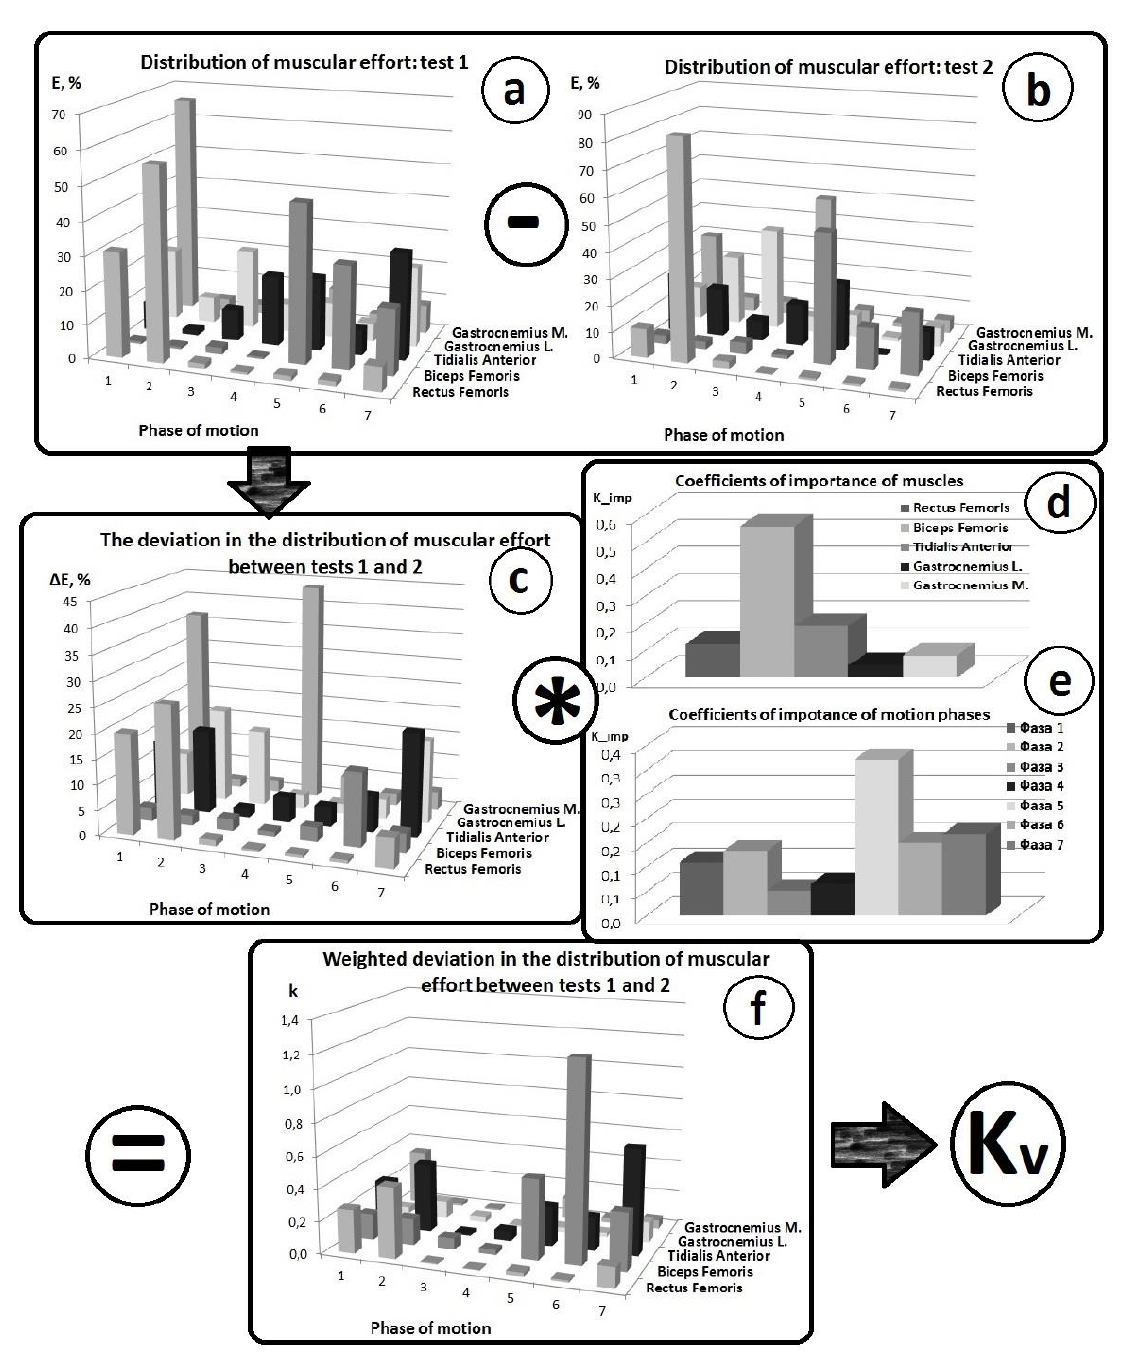
Figure 8. The stages of the estimation of the reproducibility of electromyographic patterns of motion with the influence of the external disturbing factor in the example of tests 1 and 2 for the left leg: a, b - the percentage distribution of the energy of EMG signals of the muscles in the motion phases for motion tests 1 (a) and 2 (b); c - the deviation in the percentage distribution of the energy of EMG signals of the muscles in the motion phases between the motion tests 1 and 2; d - coefficients of the muscle significance, e - coefficients of significance of the motion phases; f - weighted deviation in the percentage distribution of the energy of EMG signals of the muscles in the phases of motion between the motion tests 1 and